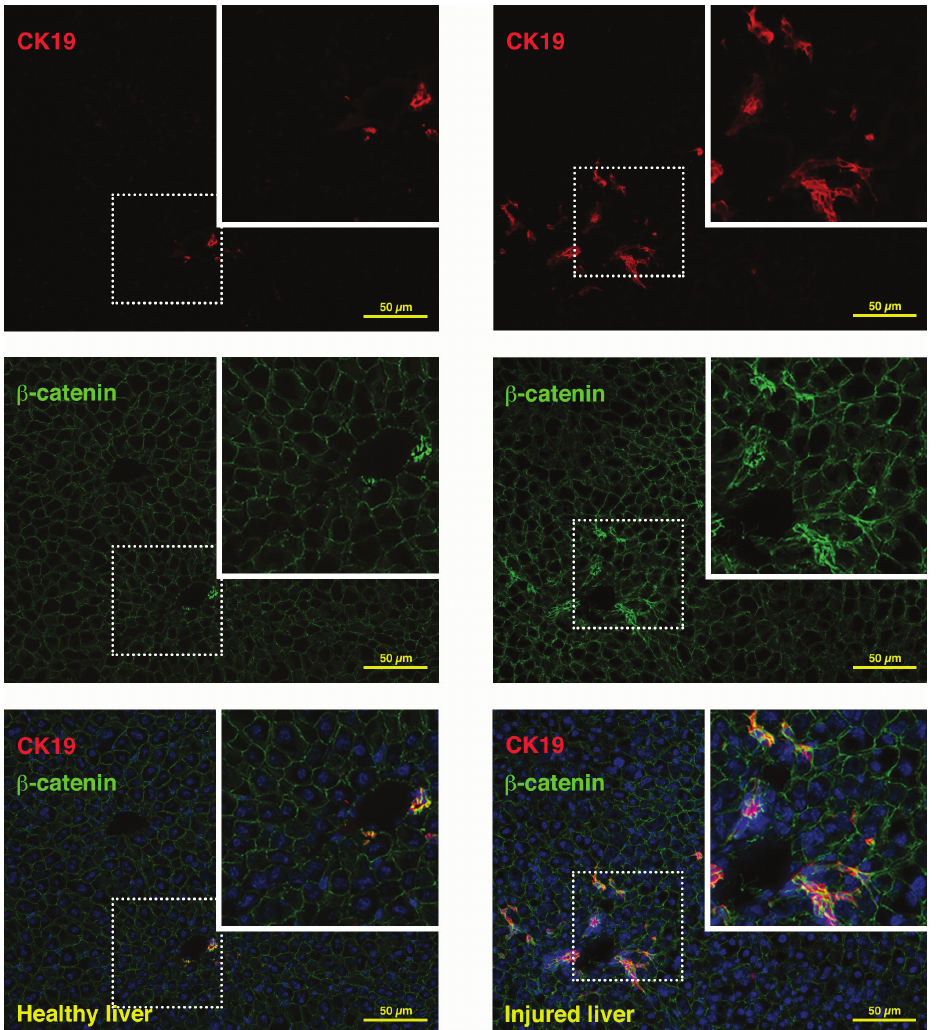
Figure 3. Beta-catenin and CK19 expression in healthy and injured liver. In healthy mouse liver, only ducts stain with an antibody targeting CK19 and show cytoplasmic and nuclear β -catenin expression, while β -catenin is exclusively membrane-bound in peri- portal hepatocytes (healthy liver, left panel). In injured liver (2-week treatment with a choline-deficient, ethionine- supplemented diet 15 ), the CK19 + compartment expands and demonstrates strong cytoplasmic and nuclear β -catenin, signifying active signalling (injured liver, right